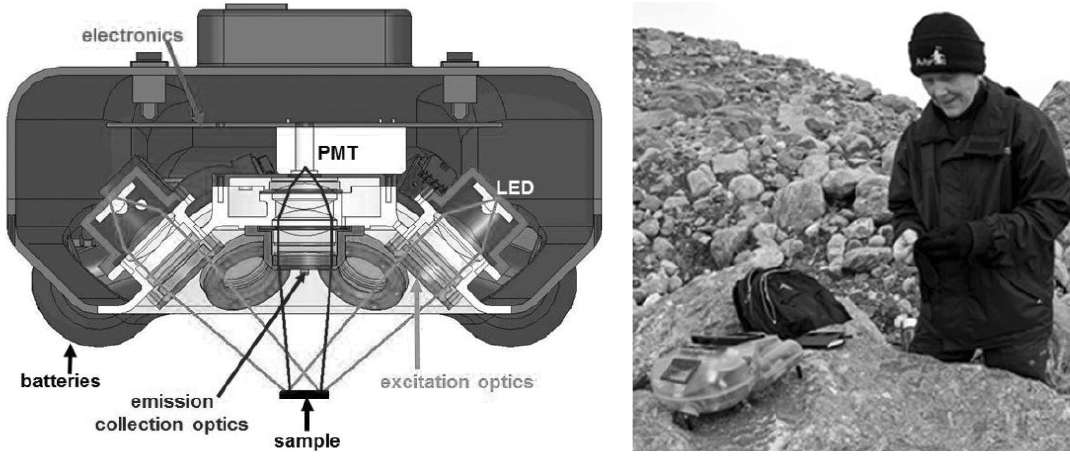
Fig. 1. Cut-away view [left] and picture [right, lower left corner] of the intrinsic °uorescence instrument used in these